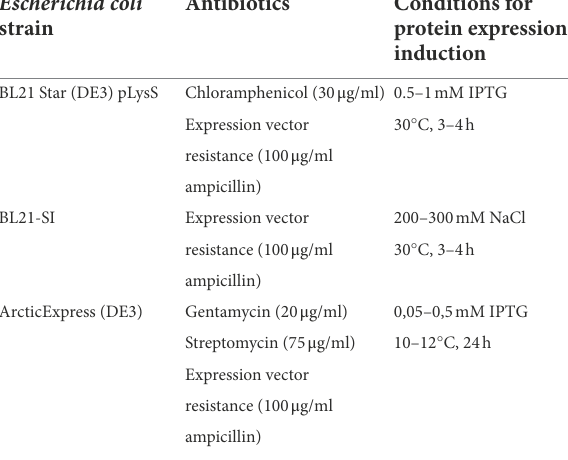
TABLE 1 Bacterial strains used and corresponding culture conditions for expression vector amplification and production of recombinant